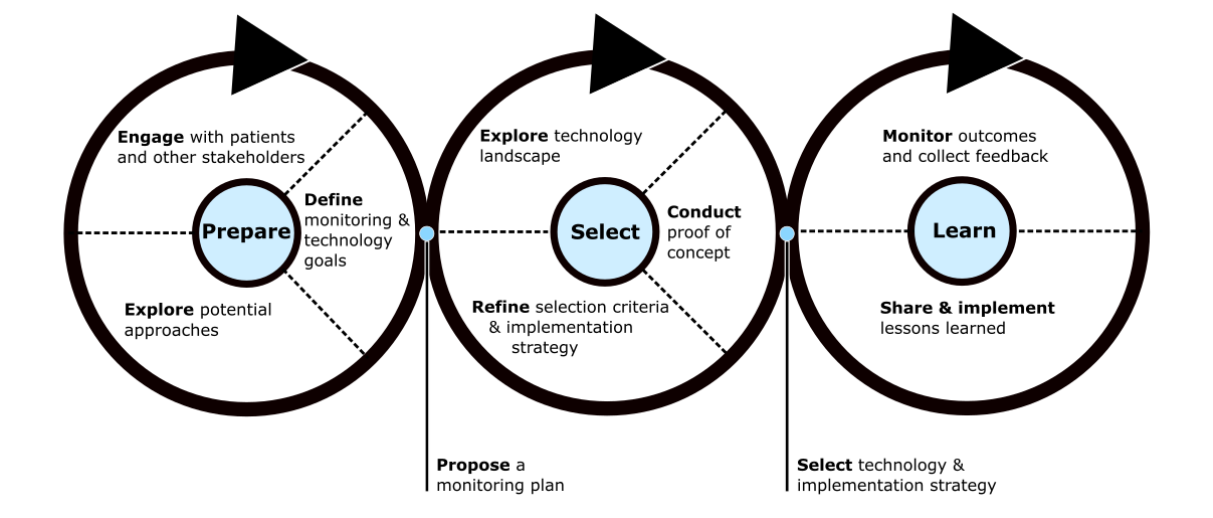
Figure 1. RADAR device selection